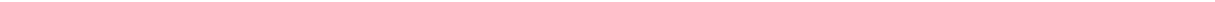
Figure 1 | Expression of TRPV1 in the hippocampus. ( a ) qPCR showing relative mRNA expression levels of the TRPV1 pore region in DRG (D) and hippocampus (H), normalized to WT DRG levels. ( b ) qPCR showing relative mRNA expression levels of the TRPV1 N-T, C-Tand pore regions (PR), and of the VR.5 0 sv splice isoform in DRG (left) and hippocampus (right) normalized to WT ( n ¼ 3 repetitions; error ¼ s.e.m., significance determined by unpaired Student’s t- test with Welch’s correction; * P o 0.05, ** P o 0.01, *** P o 0.001, **** P o 0.0001). ( c ) Western blot confirming that the N-terminal TRPV1